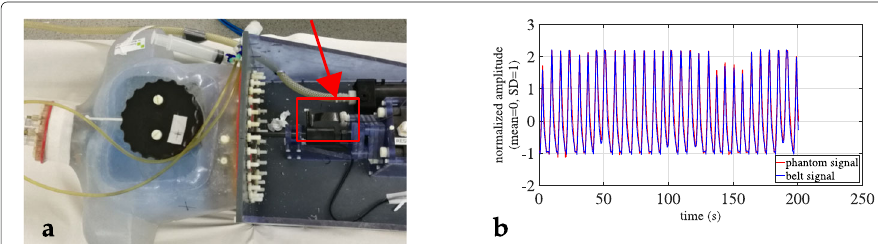
Fig. 1 Anthropomorphic thorax phantom for cardio-respiratory motion simulation in tomographic imaging [18]. a Attached ANZAI pressure sensor. b Normalized respiratory signals